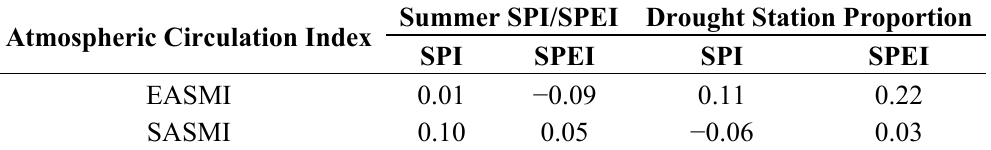
Table 4. Pearson correlation coefficients between the EASMI/SASMI and drought indicators for summer in Ningxia during the years 1972–2011.